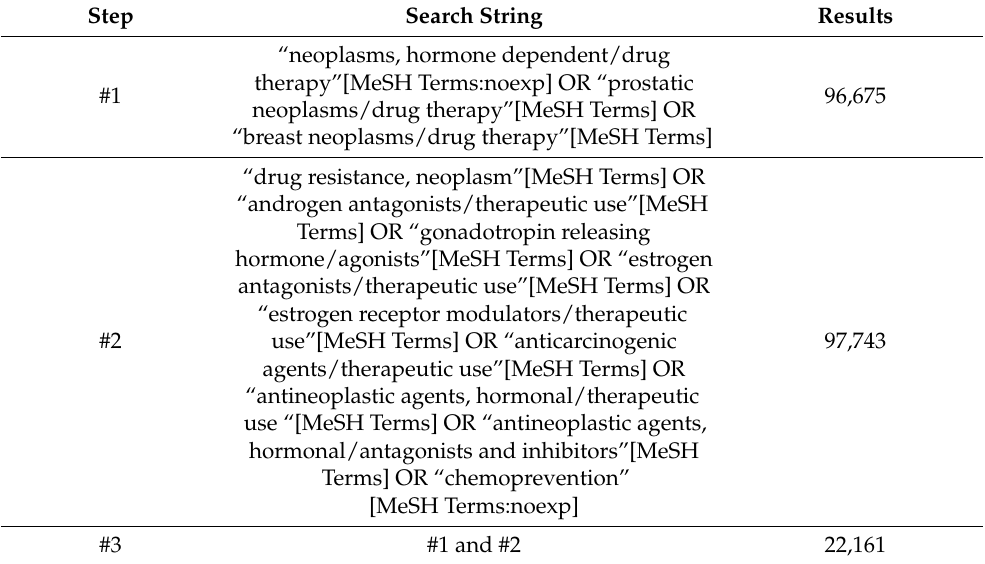
Table 2. PubMed search strategy based on the PICOS statement and inclusion/exclusion criteria, executed on 12 January